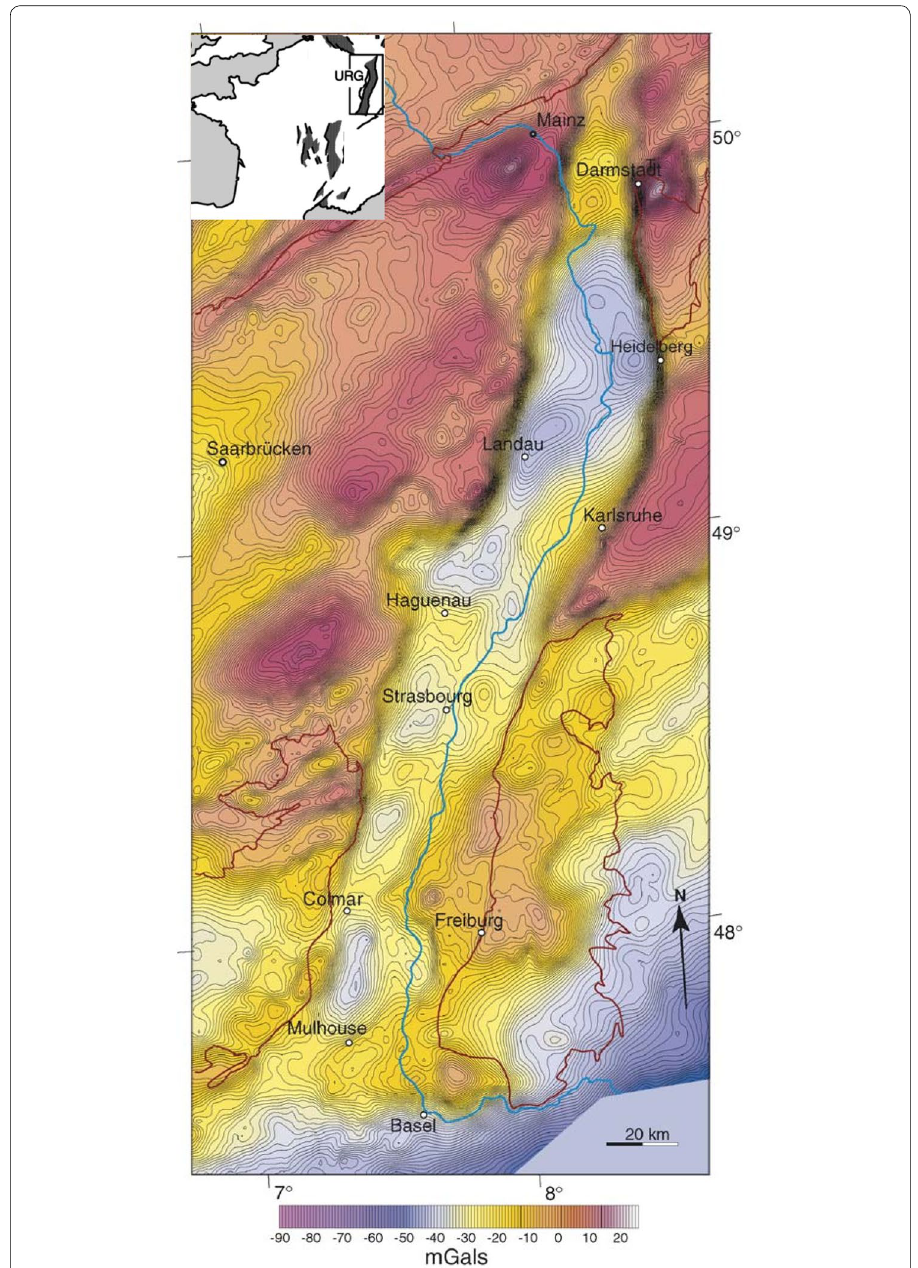
Fig. 1 Bouguer anomaly in the whole Upper Rhine Graben (URG). The reference density is 2670kg m − 3 . Location of the URG is shown in the subfigure on the top left. Vosges and Black Forest Mountains, Odenwald and Hunsruck are outlined by red lines. The black box of 10 km by 10 km corresponds to the location of the 3D THM model extension. The figure is modified after Rotstein et al.